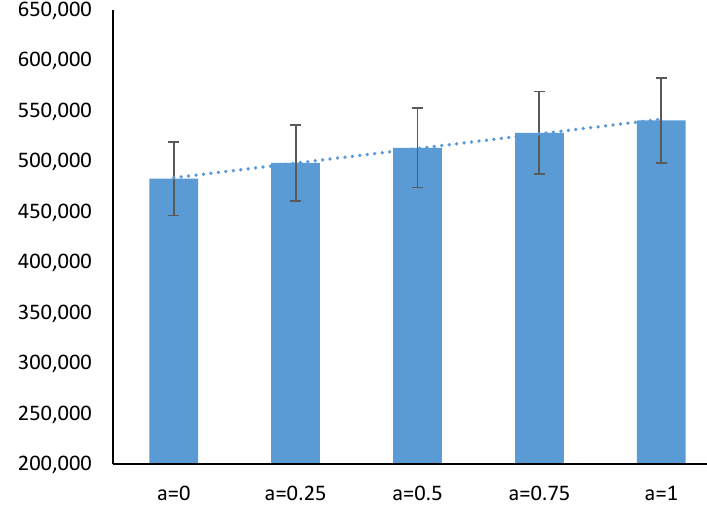
Figure 4. The total profit over the planning horizon with acceptance degrees.